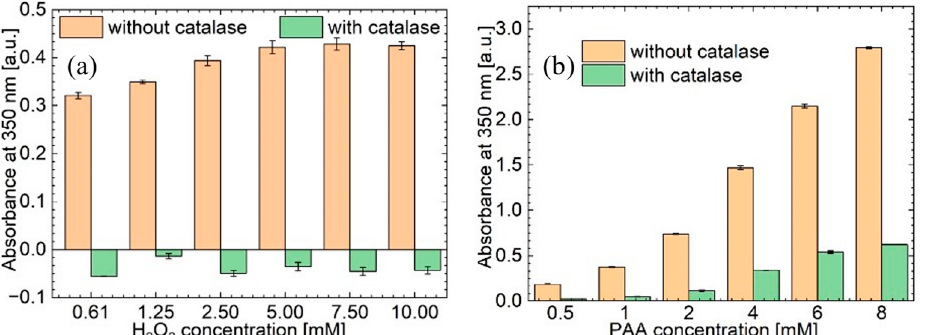
Figure 11. Oxidation of KI with different concentrations of ( a ) H 2 O 2 and ( b ) PAA with and without the presence of catalase.